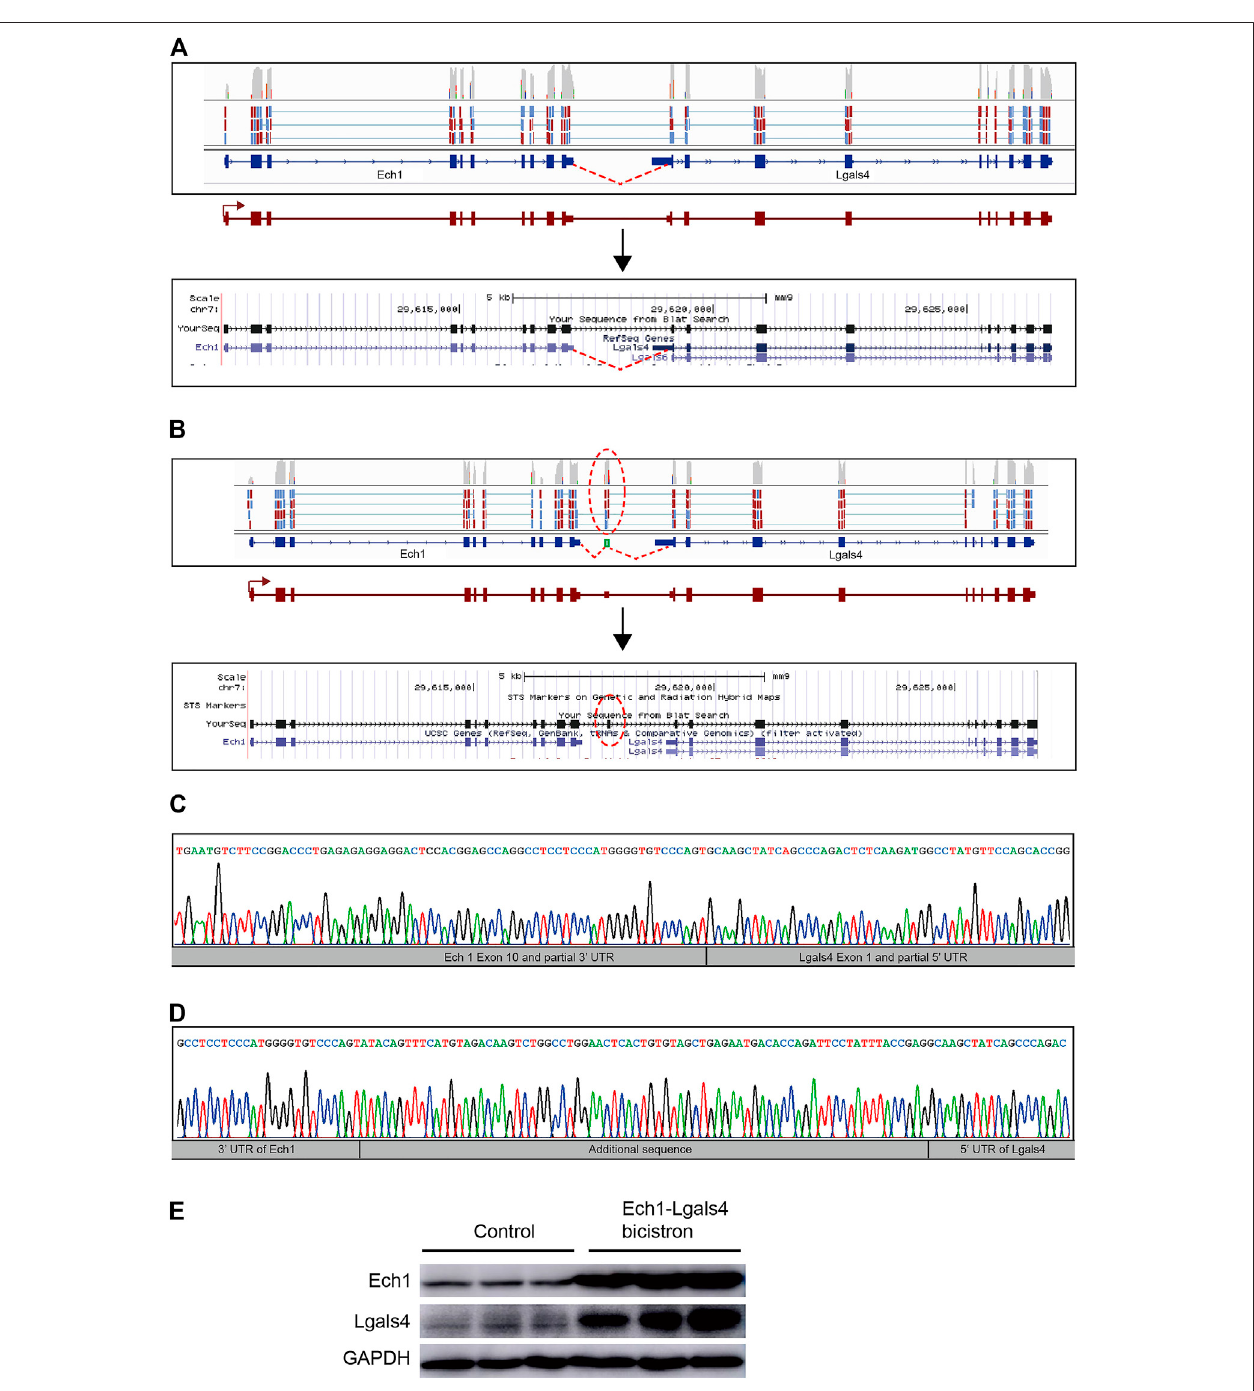
FIGURE5| Discoveryofbicistronictranscripts inquiescentNSCs. (A) Visualizationofone ofthebicistronicEch1 – Lgals4 transcripts in quiescent NSCs performed byusinganIntegratedGenomicViewer(top)andaUCSCGenomeBrowser(bottom).Novelsplice-junctionspanningreadsweredetectedfrompartial3 ′ UTRoftheEch1 transcriptintopartial5 ′ UTRoftheLgals4transcript(redlines)inRNAfromasinglecellinquiescentNSC. (B) VisualizationoftheotherbicistronicEch1-Lgals4transcriptin quiescent NSCs by using an Integrated Genomic Viewer (top) and a UCSC Genome Browser (bottom). Novel splice-junction spanning reads were detected from partial 3 ′ UTR of the Ech1 transcript into a 77 bp 5 ′ of intergenic sequence between Ech1 and Lgals4 transcripts and from a 77 bp 3 ′ of intergenic sequences between Ech1andLgals4transcriptsintopartial5 ′ UTRoftheLgals4transcript(redellipses)inRNAfromasinglecellinquiescentNSCs. (C) and (D) Sangersequencingofreverse transcriptase polymerase chain reaction products from mouse SVZ samples con fi rms the existence of bicistronic transcripts illustrated in (A) and (B) , respectively. (E) Western blot of Ech1 and Lgals4 protein expression in HEK293T transfected with the bicistronic Ech1 – Lgals4 transcript constructs.